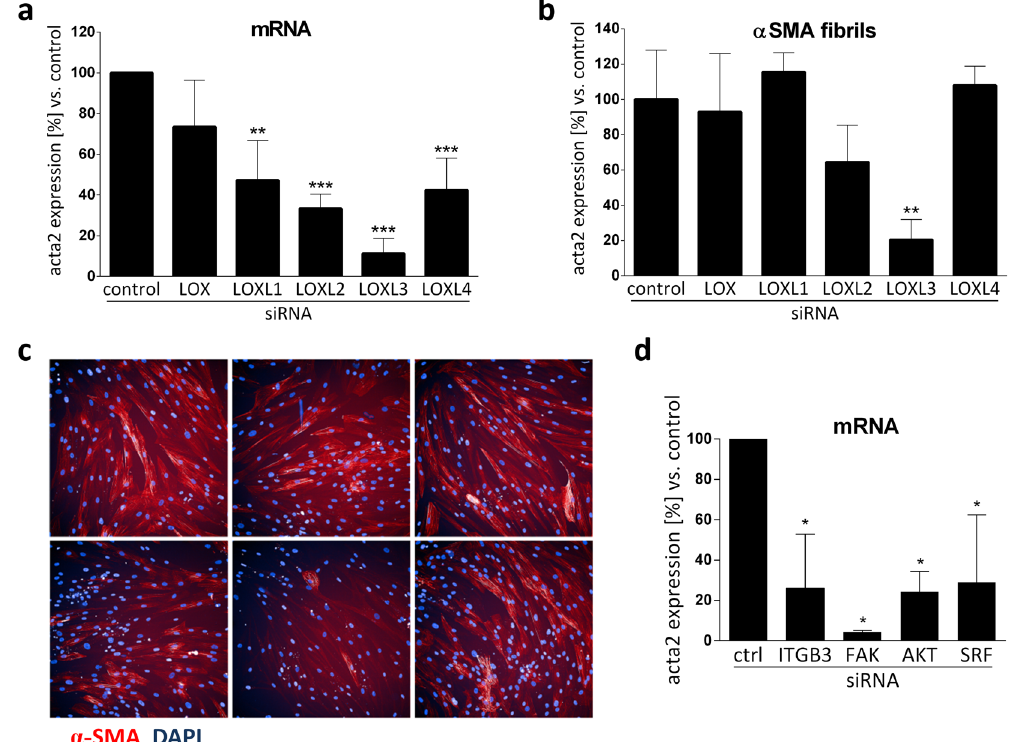
Figure 6. LOX/L knockdown leads to decreased smooth muscle actin production and stress fibre formation in NHLFs. ( a ) Primary human lung fibroblasts (NHLFs) were transfected with 16.6 nM of control, LOX, LOXL1, LOXL2, LOXL3 or LOXL4 siRNA. After 24 h, cells were stimulated with TGF- β (5 ng/ml) for 48 hours. Gene expression changes of acta2 were determined using Taqman gene expression assays and normalized to RNA-polymerase 2 expression and control treatment. The data represent the mean ± SD of three independent experiments ( ** p < 0.01; *** p < 0.001). ( b ) NHLFs were transfected as described in ( a ) and stimulated with TGF- β 1 for 72 hours. α SMA fibrils per cell were quantified after immunocytochemical staining using high- content cellular imaging of 16 wells of a 384-well plate per condition (see “Image analysis” in the methods section for details). The data represent the mean ± SD of three independent experiments ( ** p < 0.01). Representative pictures of the cells stained for α SMA (red) and nuclei (DAPI, blue) are shown in ( c ). ( d ) acta2 induction by TGF β 1 on RNA level is decreased after FAK signaling pathway depletion. NHLF were transfected with 16.6 nM of control, ITGB3, FAK, AKT or SRF siRNA. After 24 h cells were stimulated with TGF- β 1 (5 ng/ ml) for 48 hours. Gene expression changes of acta2 were determined using Taqman gene expression assays. Data was normalized to RNA-polymerase 2 expression and control treatment and is presented as mean ± SD of three independent experiments ( * p <